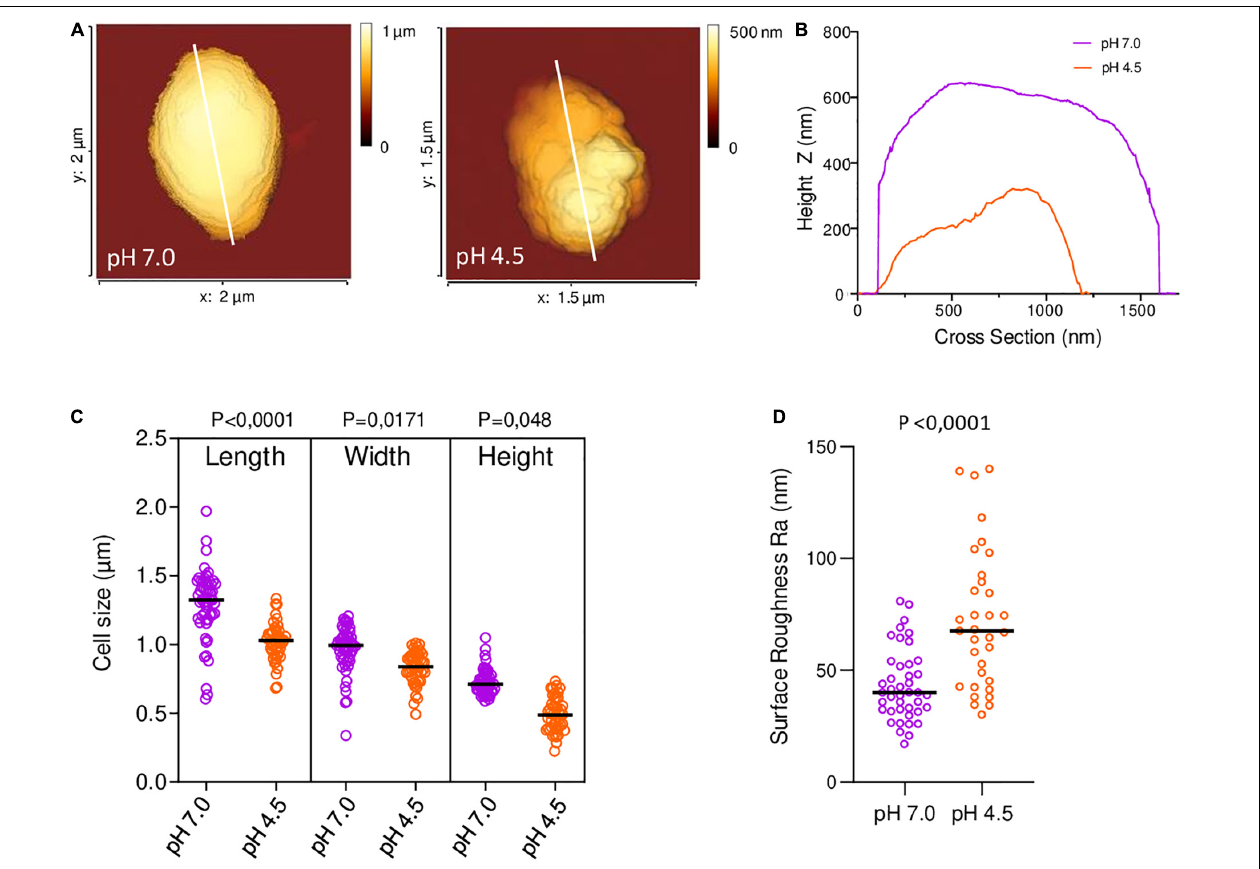
FIGURE 8 | Morphological characterization of B. microti CCM4915 in GMM pH 7.0 and pH 4.5 by Atomic Force Microscopy (AFM). (A) AFM topographic images of B. microti at both pH values. (B) Topographical profile plots measured along the longitudinal axis of the cells, indicated by solid lines in (A) . (C) Length, width and height measurements of bacteria at pH 7.0 ( n = 46) and pH 4.5 ( n = 53). (D) Average roughness R a of the bacteria at pH 7.0 ( n = 42) and pH 4.5 ( n = 33), based on recorded surface roughness. Cell height analysis was carried out using the height (measured) channel of the QI mode, which corresponds to the height at 80% of the setpoint force determined on the reference force-distance curve. Height was calculated as the topographical maximal central height on each cell using the section tool of the analysis software. The average roughness (Ra) was calculated on the z channel values using a 400 × 400 nm area for each cell. Statistical differences were analyzed by t -test and yielded P values < 0.05, as indicated for panels (C) and (D)